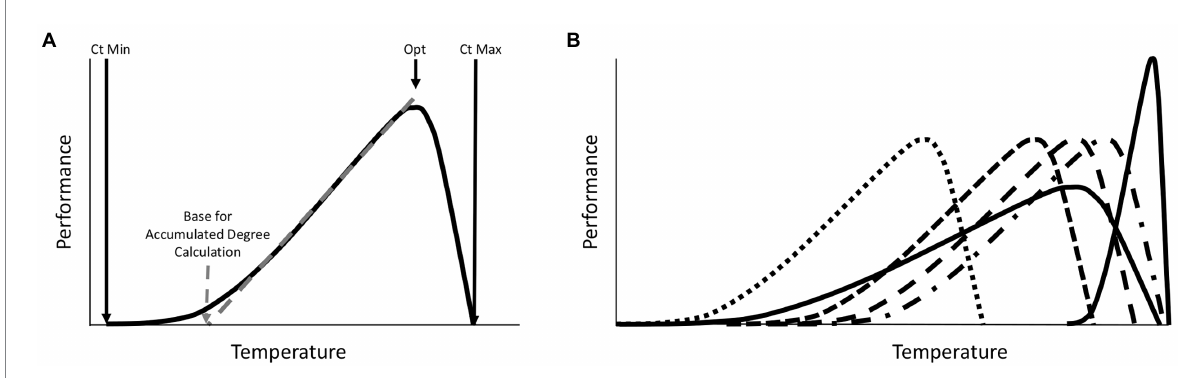
FIGURE 1 Expectations for a general phenotypic performance response to temperature for one species. (A) All phenotypes for all organisms exhibit a thermal performance range defined by the Critical Thermal Minimum (Ct Min) and Critical Thermal Maximum (Ct Max). Responses are typically skewed such that optimal performance is closer to Ct Max than Ct Min. Changes in performance with increasing temperature are usually shallower at lower temperatures and steeper at higher temperatures. For some portion of the thermal performance curve the response to temperature is relatively linear and can be predicted with simple linear accumulated degree models. The base temperature for such models (below which development is assumed to be zero) is defined by the intercept of this linear response with the temperature axis at the point where performance is zero. This linear range is a subset of the full thermal performance curve. Outside of this range, thermal predictions can be biased if linear models are applied. Organisms often regulate their temperatures by orienting close to, but usually not exactly, their optimal temperatures (Opt), which can vary across phenotypes, environments, and genotypes studied. (B) A theoretical distribution of thermal performance for a community of organisms, where each species has distinct thermal performance curves, with different thermal minima, maxima, and optima, which reveals patterns for thermal specialist or generalist, and where some species may or may not co-occur due to differences in thermal performance. The members of the community have different optima, different base temperatures for accumulated degree calculations, and different thermal ranges are covered by the linear portions of the thermal responses of individual community members. Such community members may be informative of an ecological process in different thermal conditions, but imposing a single thermal assumption on a whole community of organisms is more problematic than predictions of one well understood